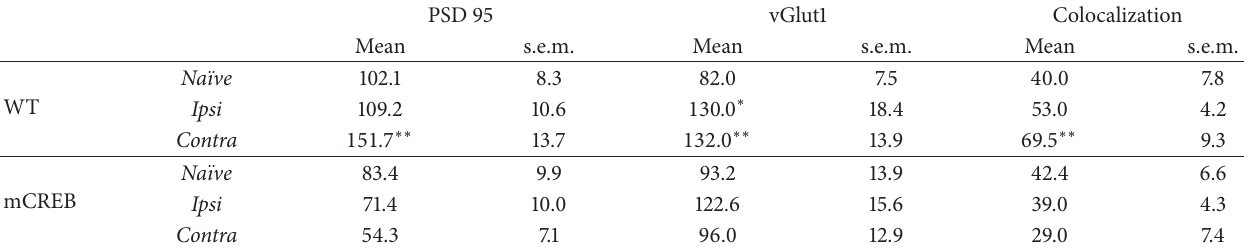
Table 1: Number of vGlut1 and PSD 95 positive puncta and number of colocalizations in the six experimental